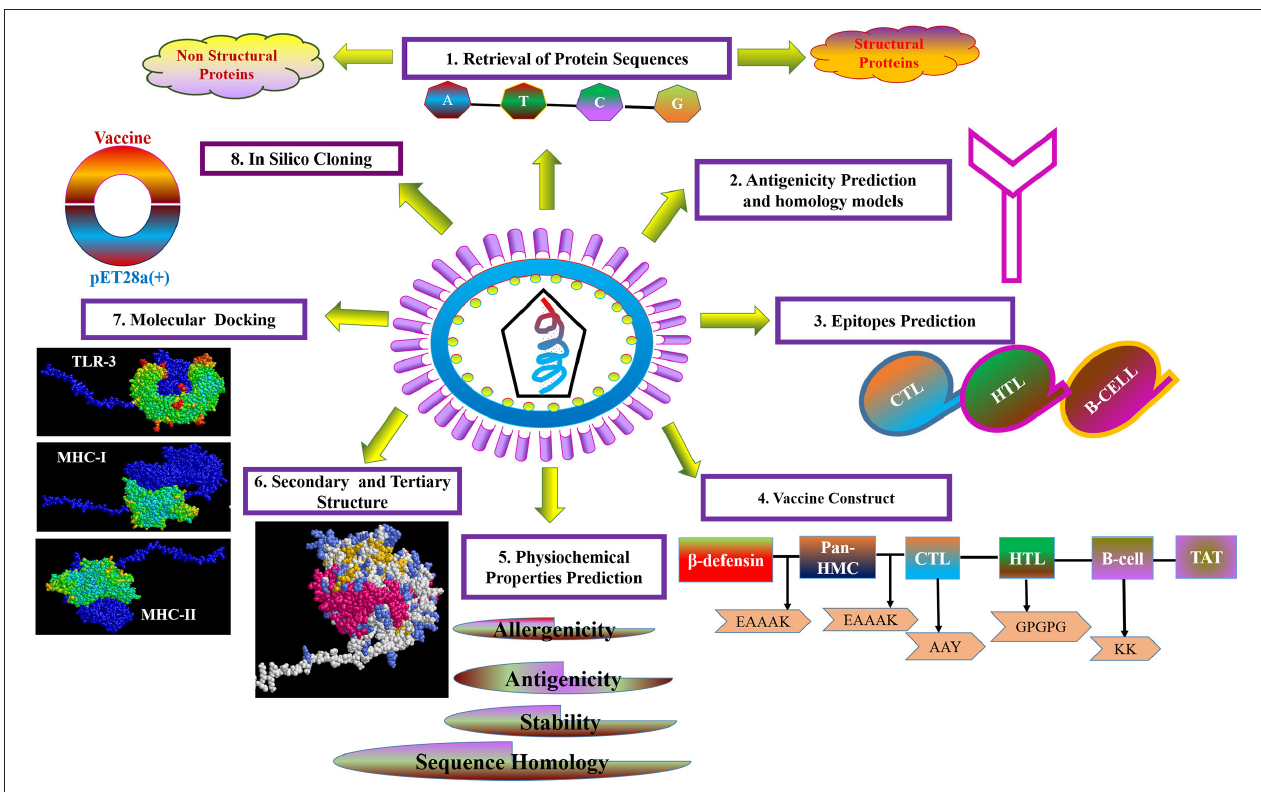
FIGURE 1 | Flow diagram of design strategy, representing the steps of the construct of the multi-epitope subunit vaccine.